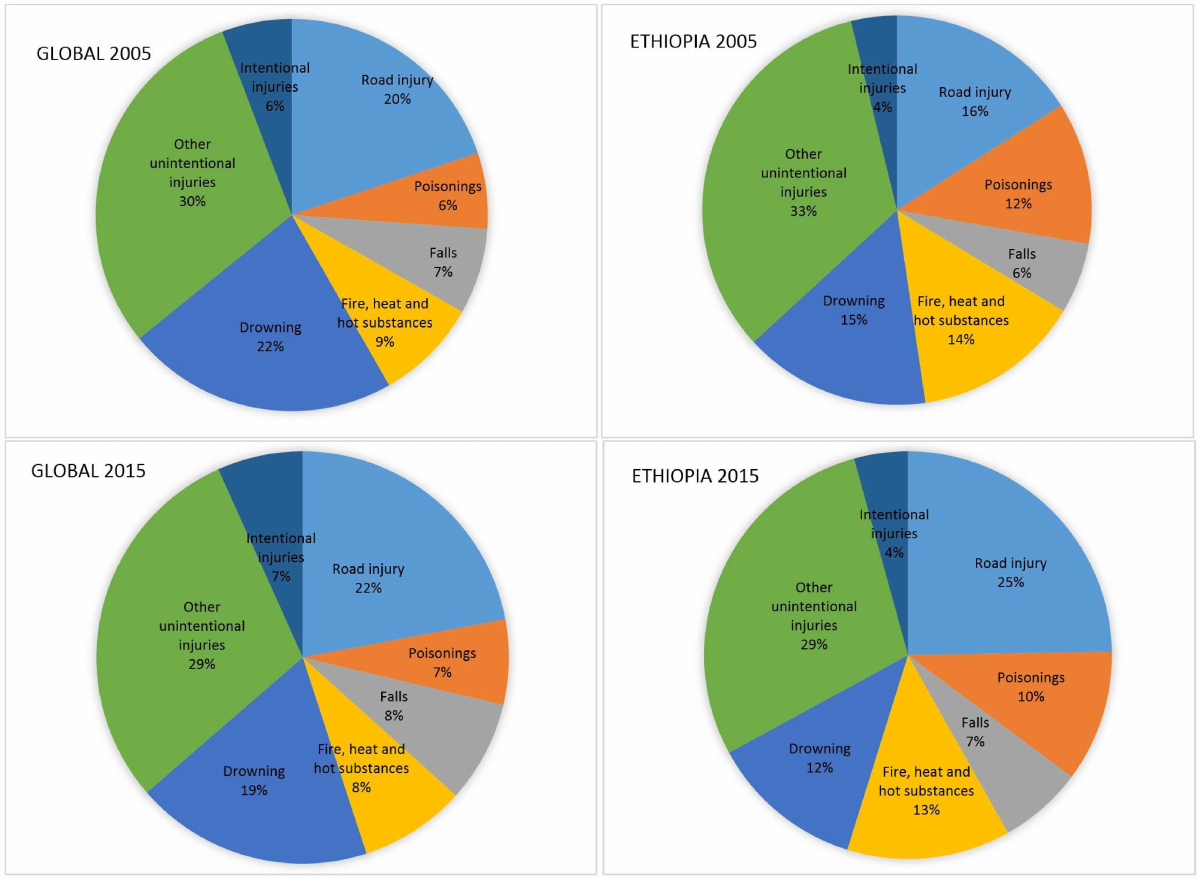
Fig 1. Under-five injury deaths by cause globally and in Ethiopia, 2005 and 2015. Source: Global Health Estimates 2017.